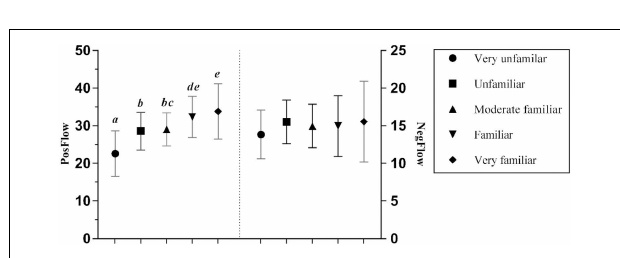
FIGURE 8 | The effects of students’ familiarity with technology use on PosFlow and NegFlow (Means and Significant